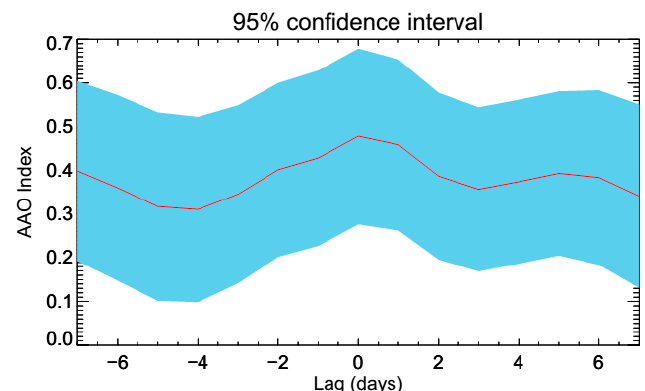
Figure 3. Average AAO index (red line) during the previous week (lag = –7 days) up to a week after (lag = +7 days) at the beginning of SACZ events (lag = 0). The blue shaded area is the 95% confidence interval, assuming normality.